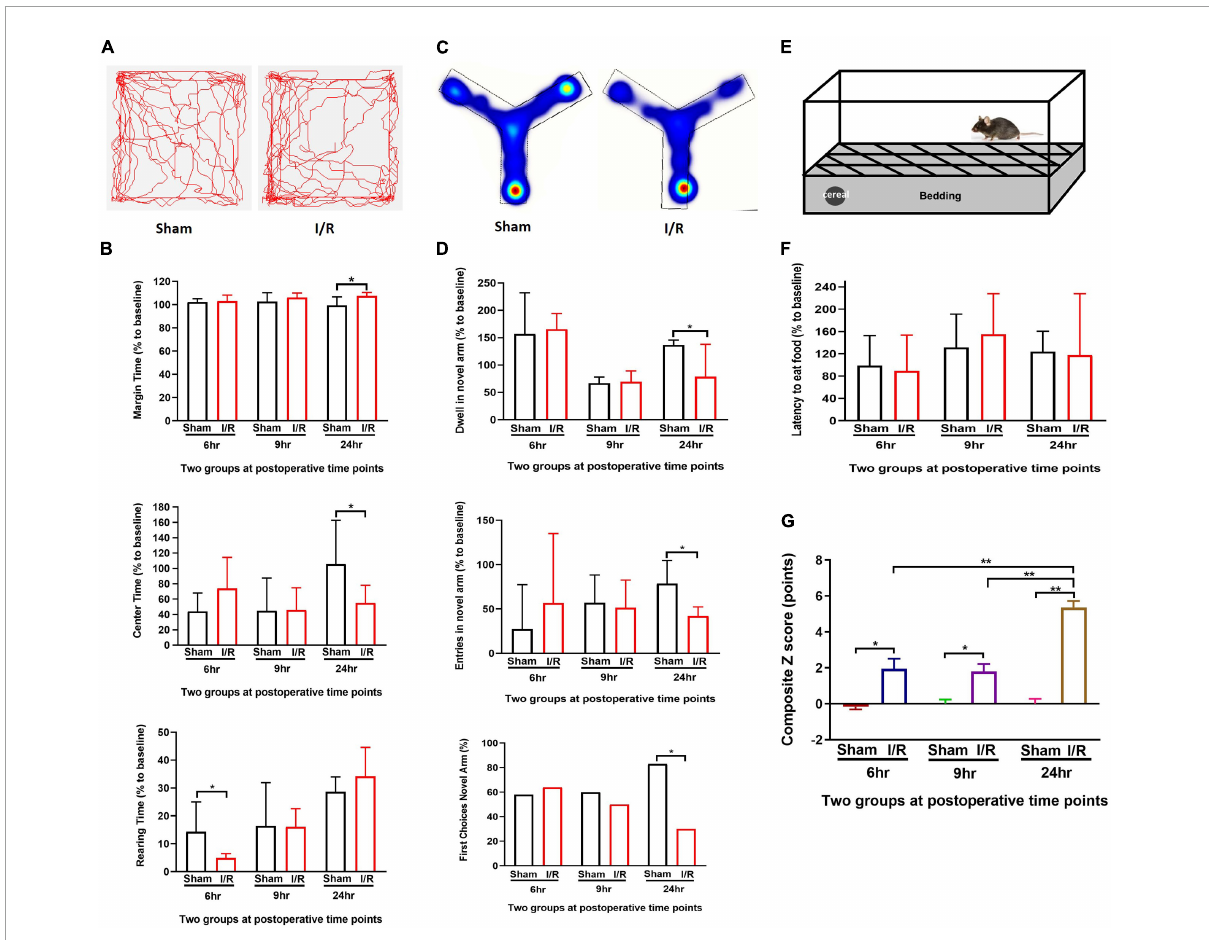
FIGURE2 Repeated I/R surgery of small intestine disturbed the behaviors in mice at postoperative 6, 9, and 24 h which had higher composite Z scores. (A) Open Field Test. (B) Y Maze Test. (C) Buried Food Test. (D) Track map of Open Field Test. (E) Heating map of Y Maze Test. (F) Composite Z score of each mouse. (G) Summary of composite Z scores. The percentage data were presented as median (IQR). Composite Z score was presented as Mean ± SD. Larger values of composite Z score suggest severer impairment. N = 10 per group, * P < 0.05, ** P < 0.01. I/R: ischemia and reperfusion, hr: